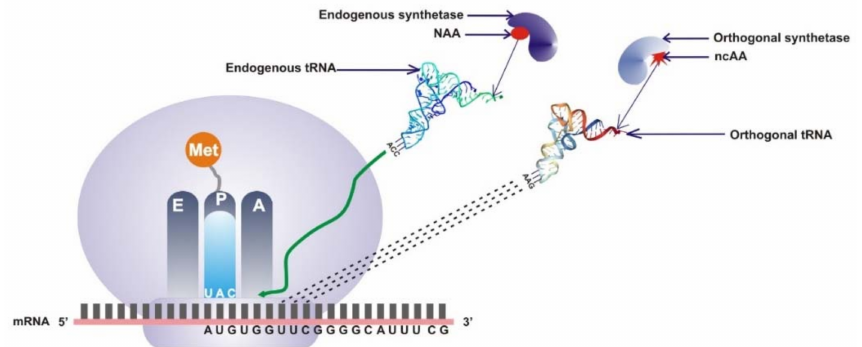
Figure 1. Schematic illustration of the general principles for the site-specific incorporation of ncAA into proteins in vivo. The natural translational system involves the activity of endogenous synthetase, which charges the endogenous tRNA with natural amino acids (NAAs), which is presented as a red oval shape. The orthogonal translational system is applied to site-specifically incorporate ncAA into proteins. Orthogonal aminoacyl-tRNA synthetase acylates the orthogonal tRNA with a noncanonical amino acid. The acylated orthogonal tRNA introduces the ncAA at a specific site complementary to the unique codon, thereby incorporating it into the ORF that encodes the protein of interest (ncAA is represented by the red